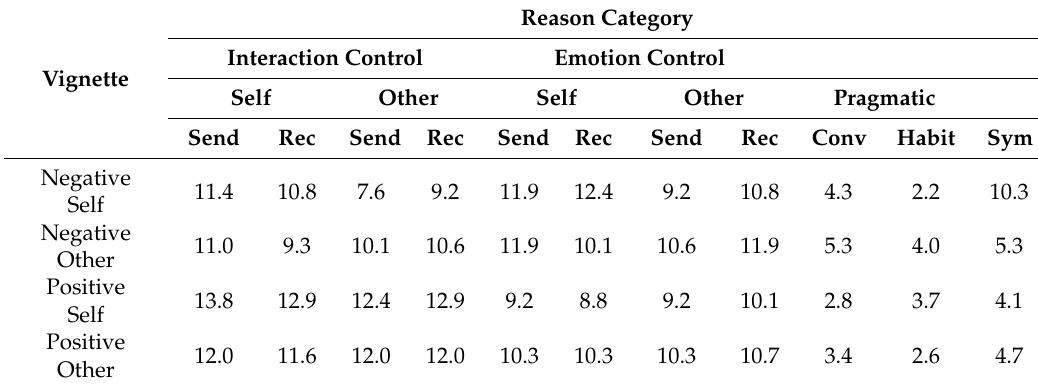
Table 2. Relative frequencies [% of row] of reason categories for each vignette 1,2 .